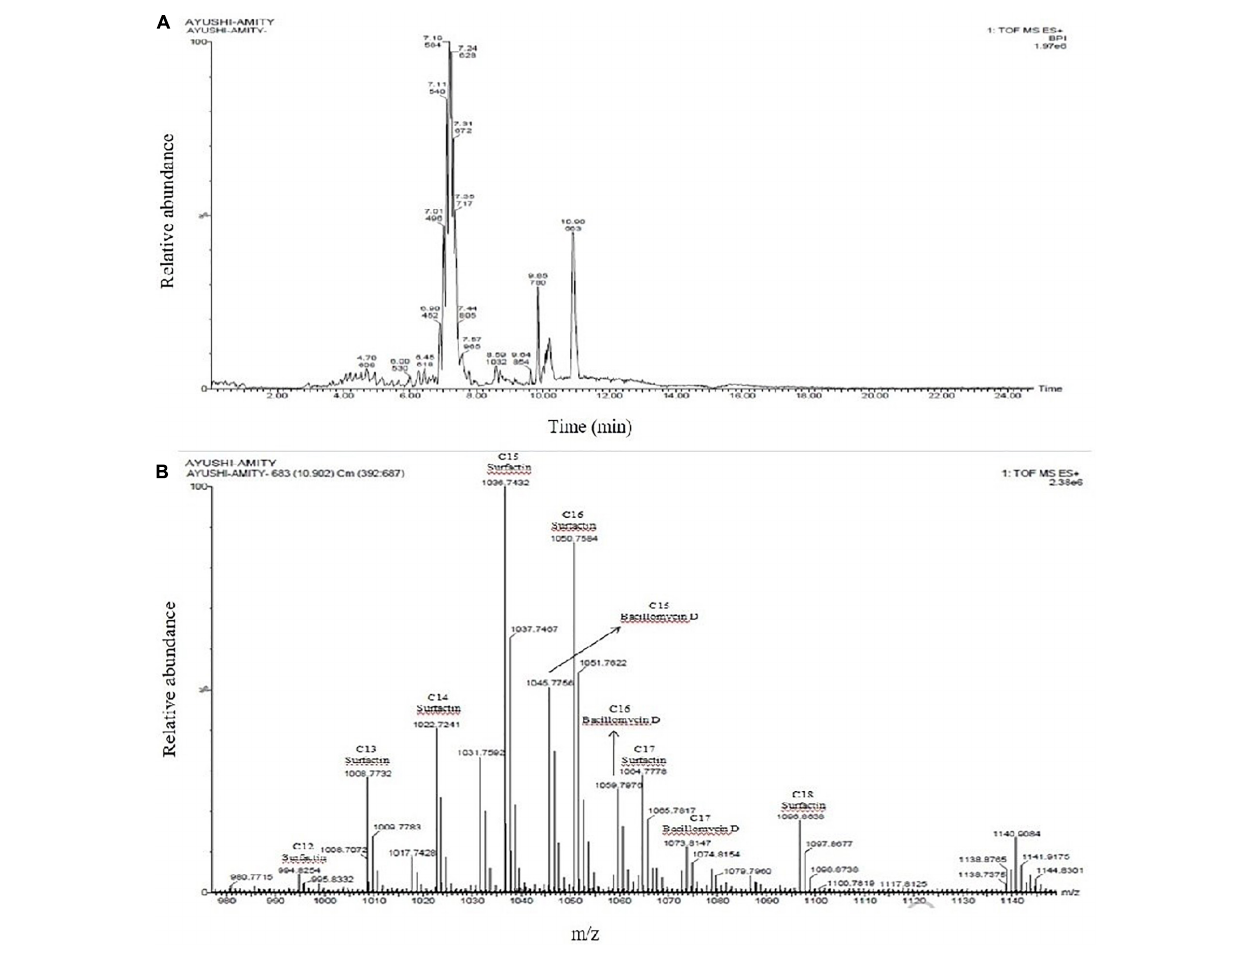
FIGURE 7 | (A) UPLC chromatogram of lipopeptides extracted from Bacillus siamensis strain NKIT9; (B) HDMS accurate mass revealed the production of Surfactin and Bacillomycin D